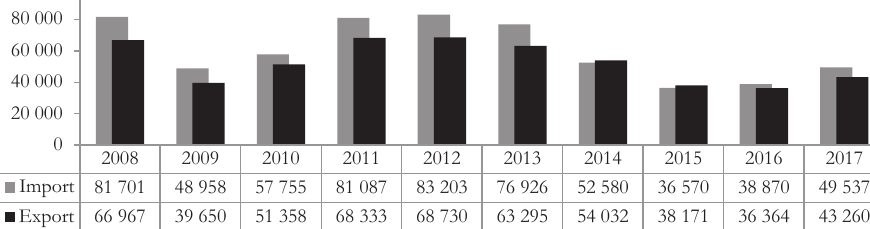
Fig. 8 – External of Ukrainian commodities in 2008-2017, billon US dollars. Source: State Fiscal Service of Ukraine,